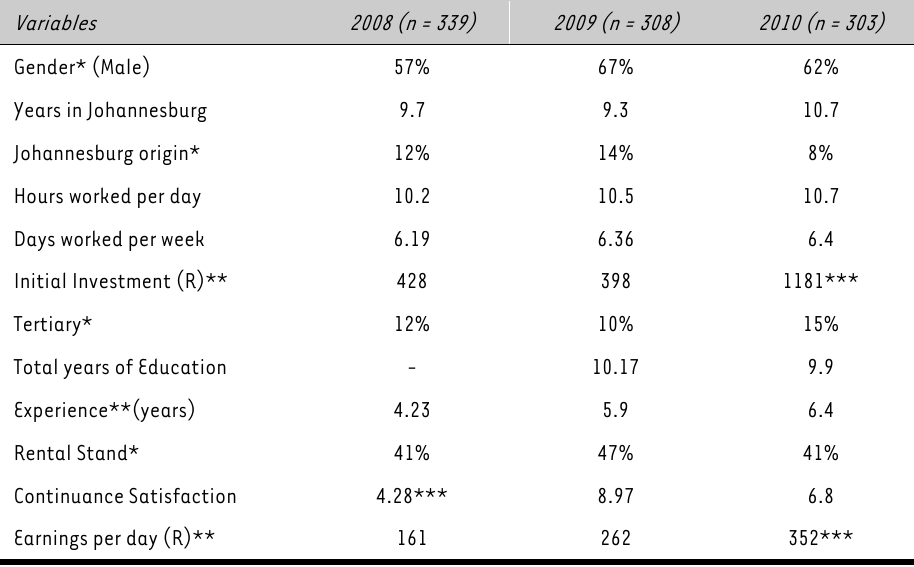
TABLE A1: Comparative Descriptive Statistics: Means and Frequencies Variables